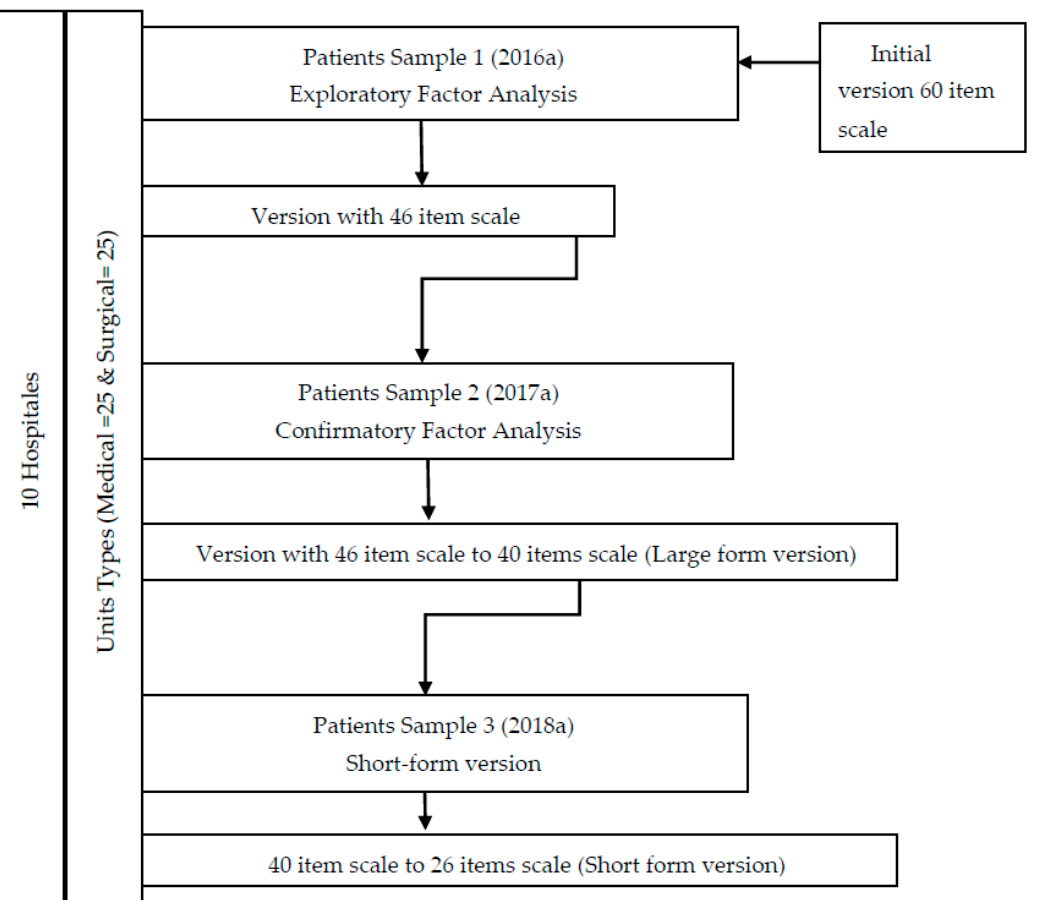
Figure 1. Description process two versions of the instrument: a 40-item and 26-item version.